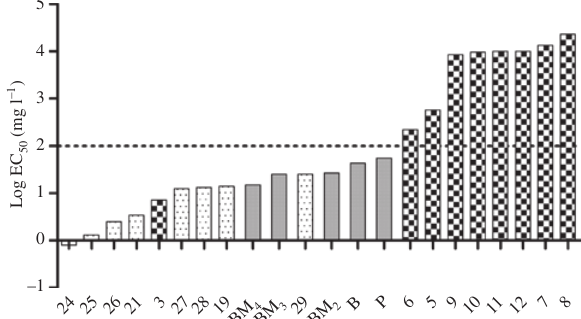
graphical comparison of toxicity in Daphnia Figure 4: Log EC 50 magna. The codification is shown in Table 2. Pointed bars correspond with imidazolium ILs, squared bars correspond with traditional solvents and grey bars correspond with the studied ILs. The dashed line shows the limit between slightly toxic and practically harmless compounds according to Passino and Smith